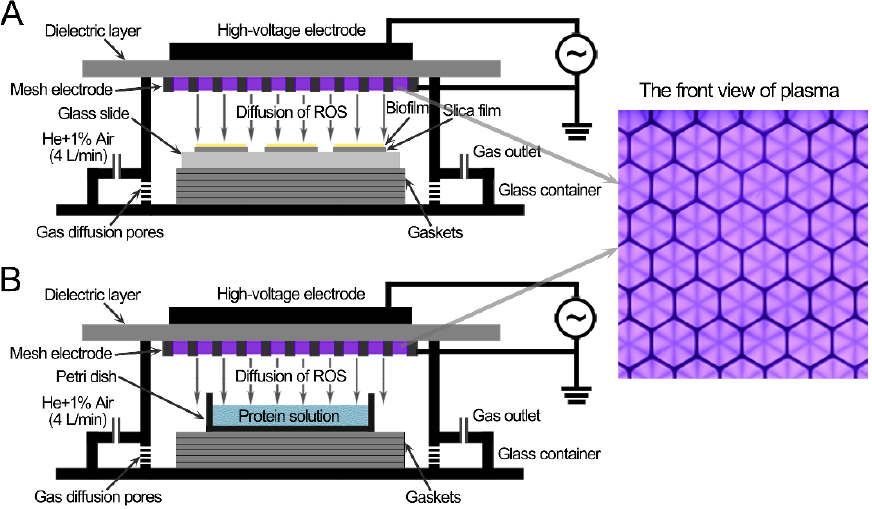
Figure 1. Schematic diagram of the S. aureus biofilms ( A ) and the protein solutions ( B ) treated with the surface discharge of cold atmospheric-pressure plasma. the surface discharge of cold atmospheric-pressure